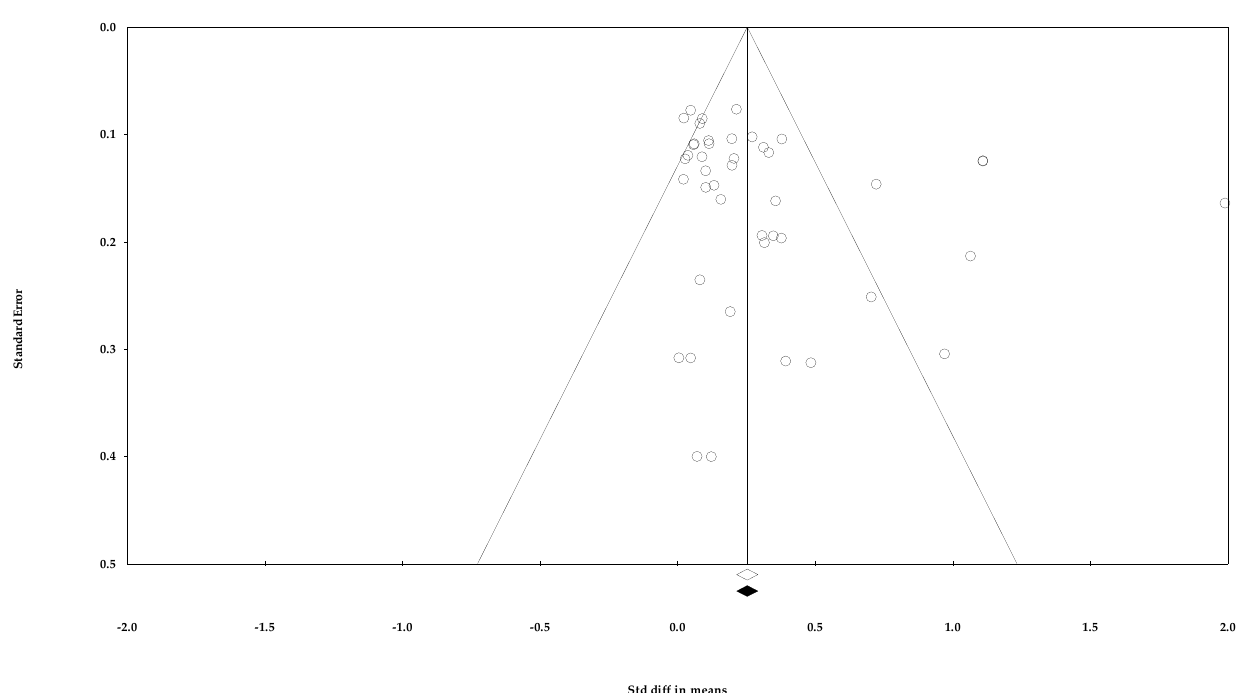
Figure 3. A funnel plot of standardized mean difference in diastolic blood pressure. Note: summary effect size ( ◇ ), sum- mary effect size of imputed studies ( ◆ ), individual study ( ○ ).